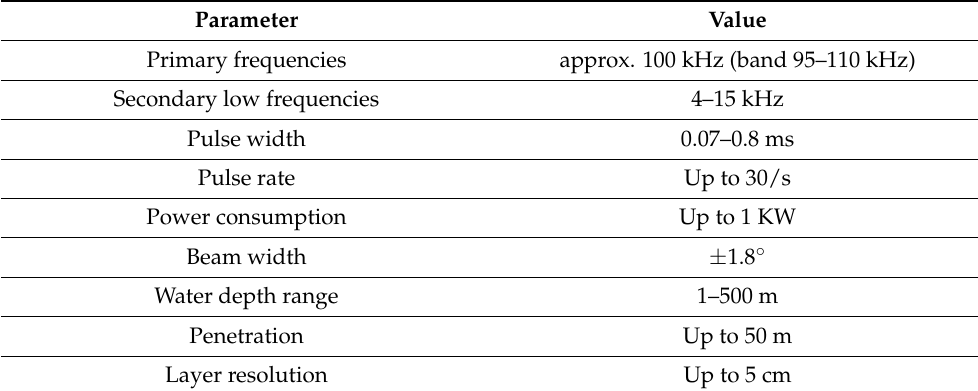
Figure 3. Components of the sub-bottom profiler SES-2000 Standard: SBP transducer with cable ( a ), positioning sensor ( b ), topside unit ( c ). Table 2. Main technical characteristics of the sub-bottom profiler SES-2000